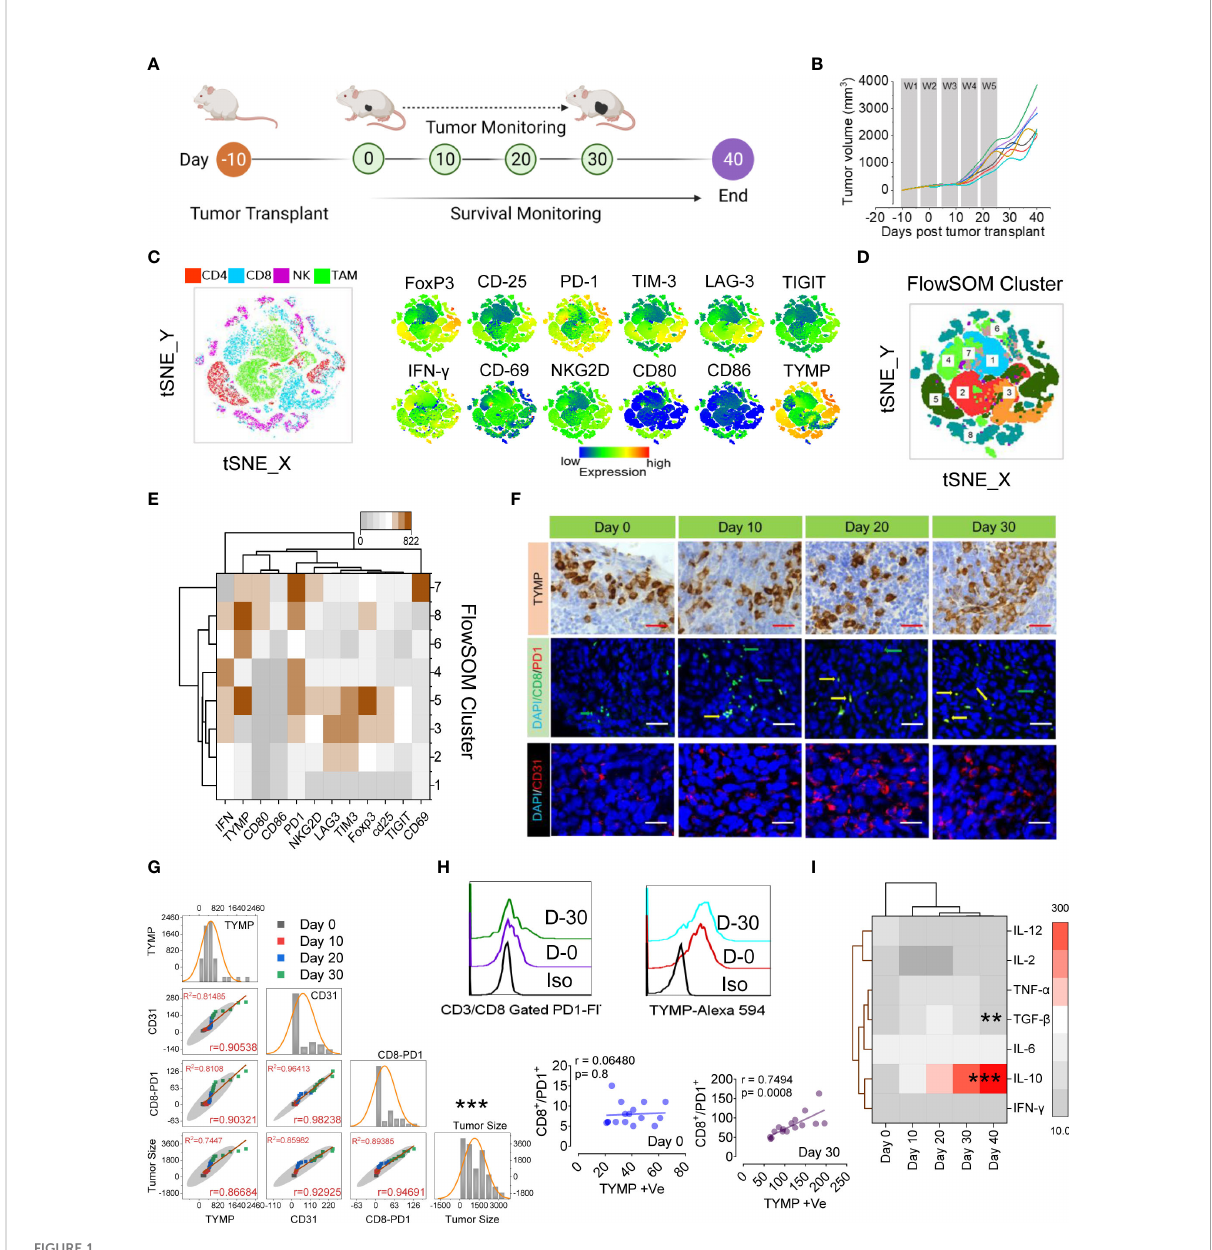
FIGURE 1 PD1 Hi T cells and increased Treg cells correlate with TYMP overexpression in colorectal carcinoma, which results in poor prognosis and survival. (A) Experimental schedule; after 10 days of s.c. inoculation with 5 × 10 4 CT-26 cells, the tumors reached approximately 90 mm 3 , and tumor monitoring was initiated (noted as Day 0). (B) The tumor growth curves, (C) tSNE map of CD4 + T cells in TILs (red dots), CD8 + T cells (blue dots), NKG2D + NK cells (pink dots) and CD11b + /Gr-1 lo TAM cells (green dots) of the polled CRC tumors (n = 6). tSNE maps showing the expression level and the distribution of each indicated marker. The color scale indicates the relative expression levels. (D) tSNE projection of CD8 T-cell clusters identi fi ed by FlowSOM clustering. (E) Mean fl uorescence intensity (MFI) as indicated (column-scaled z scores) markers for selected clusters. The color scale indicates the relative expression levels. (F) IHC analysis of TYMP (top), double immuno fl uorescence staining for PD-1 and CD8 (middle) and immuno fl uorescence analysis of CD31 (bottom) in CRC tumors at the indicated time points. (G) Multivariate scatter plot matrix correlation analysis showing histograms, absolute correlations, and correlation coef fi cients (r) for the relationship between TYMP, CD31, and CD8-PD1 cells and the tumor growth rate over time. (H) Representative PD1 expression in CD3/CD8-gated TILs and TYMP expression in CRC tumors at days 0 and 30. Linear regression analysis with a linear mixed model showing the relationship between CD8 + /PD1 + cells and TYMP expression in tumors on the indicated days. (I) Heatmap showing the normalized cytokine expression level in serum. The color scale indicates the relative expression levels. Signi fi cance was determined by an unpaired Wilcoxon test with Benjamini and Hochberg correction. Unless otherwise noted, the data are presented as independent biological triplicates. In vivo studies were repeated independently fi ve times to con fi rm the results. *p < 0.05, **p < 0.01, ***p <